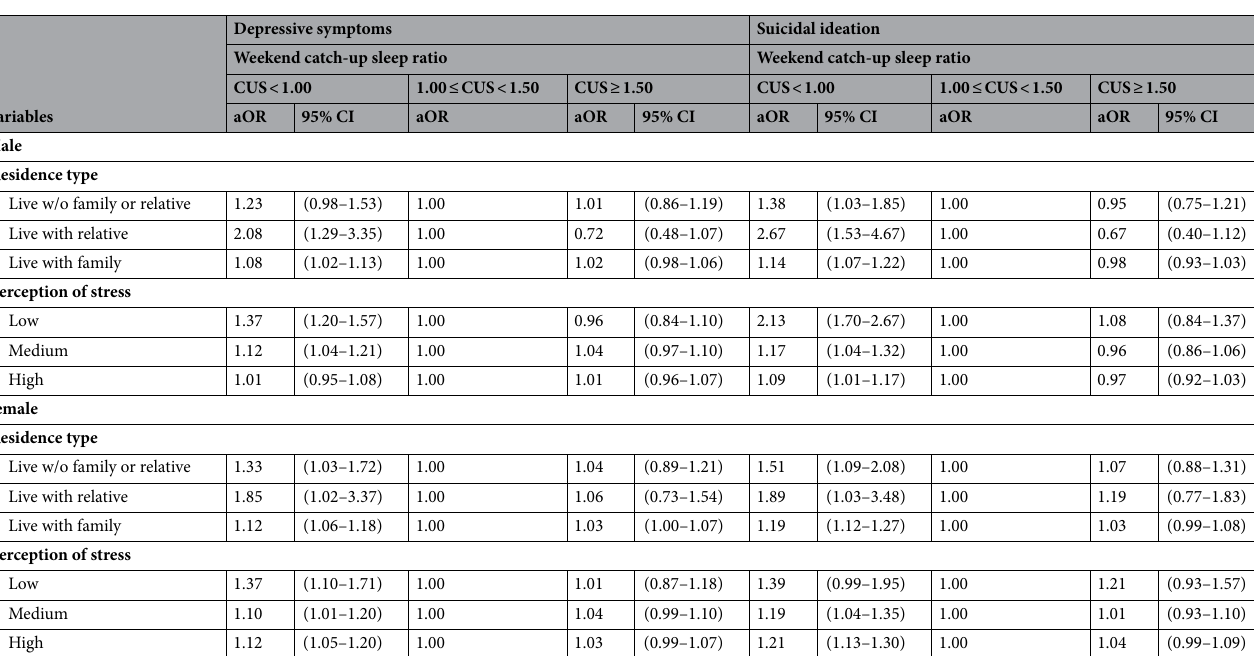
Table 3. Results of analyses of association of weekend catch-up sleep ratio with depressive symptoms and suicidal ideation stratified by independent variables after adjusting for all covariates. CUS catch-up sleep, w/o without, aOR adjusted odds ratio, CI Confidence